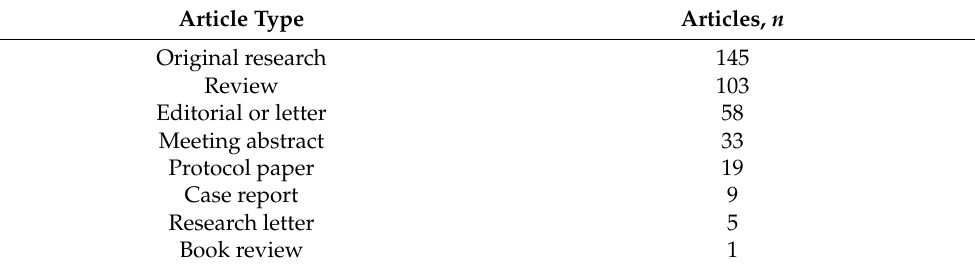
Figure 1. Study inclusion flowchart. ICU, intensive care unit; PICS, post-intensive care syndrome. Table 1. Articles on post-intensive care syndrome, by article type.